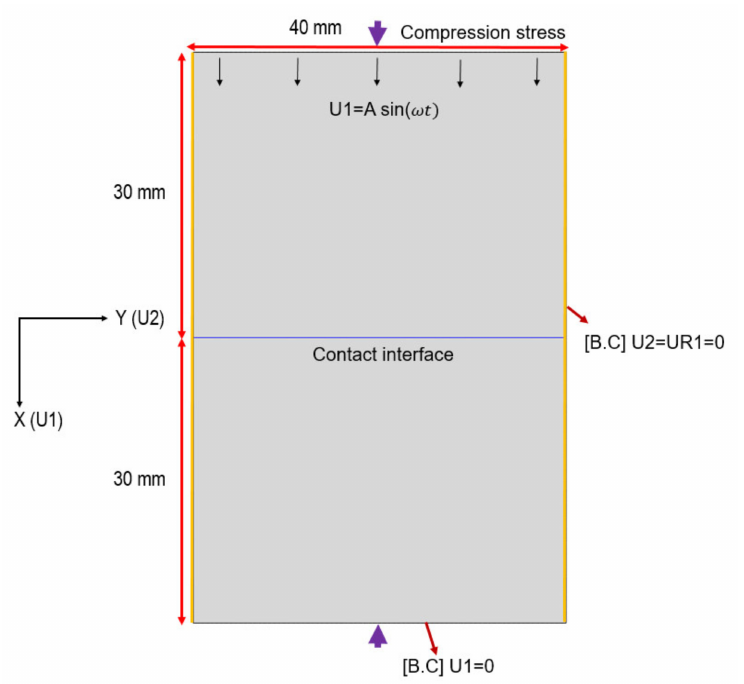
Figure 3. Two-dimensional contact model for FEM